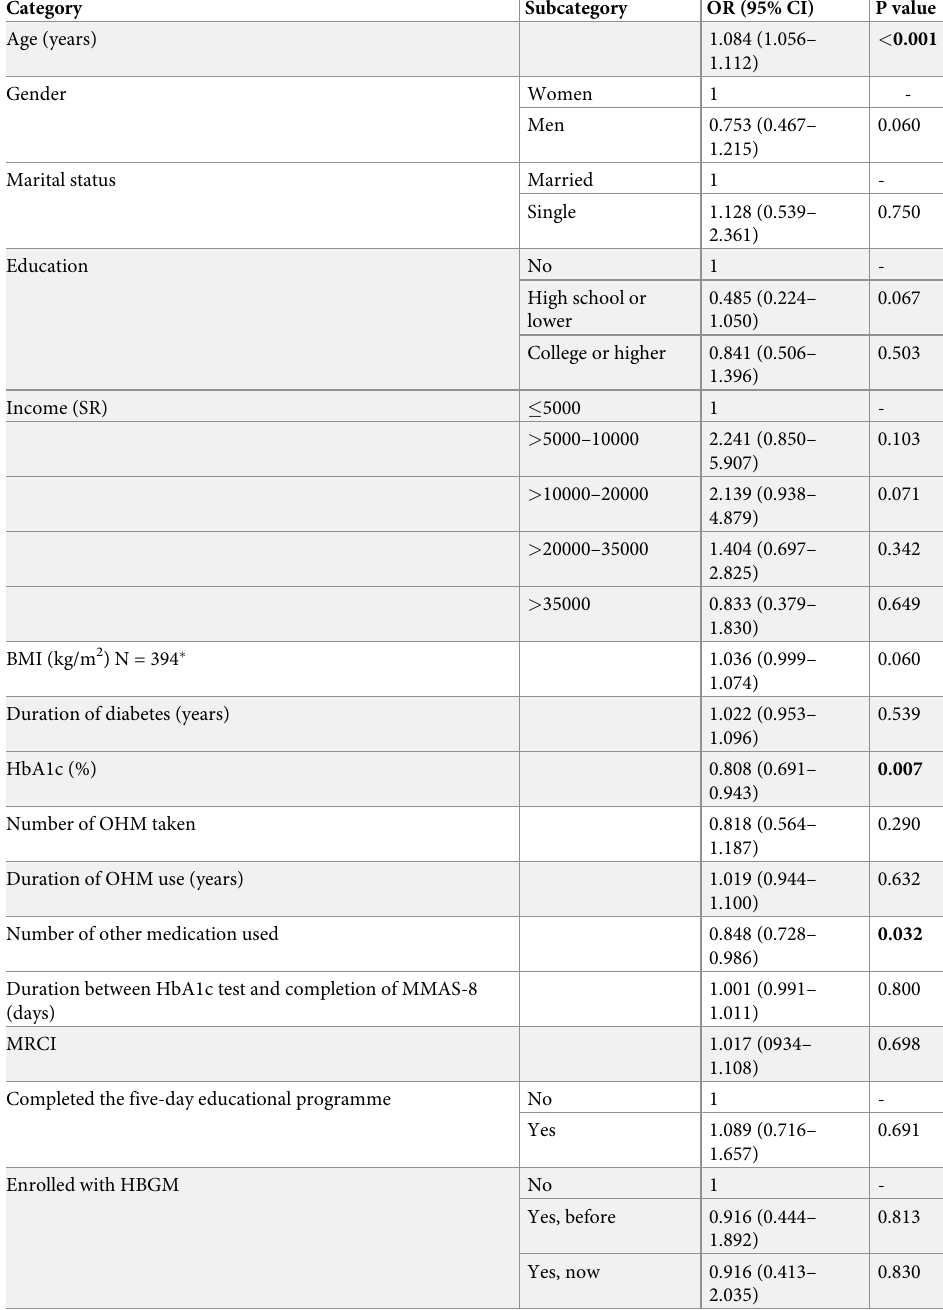
Table 2. Factors predicting OHM adherence using ordinal logistic regression